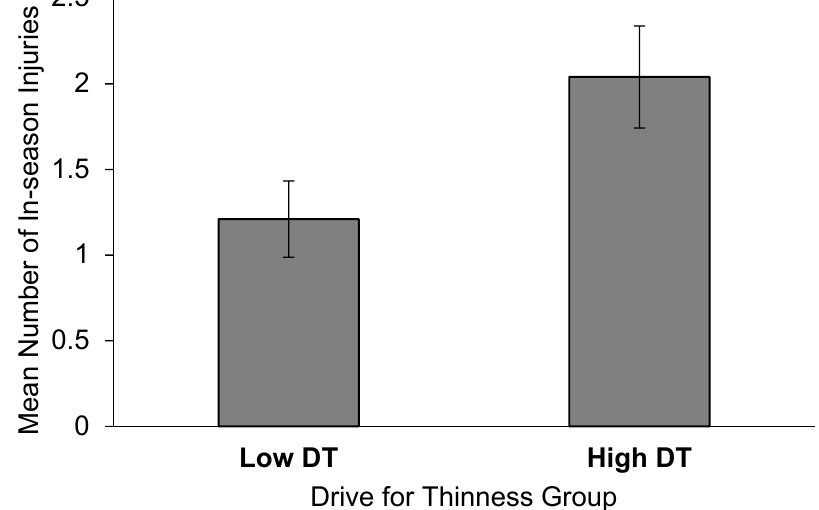
Figure 1. The mean number of in-season injuries in women high drive for thinness (High DT, determined by a median split) was higher ( p < 0.05) than the women with a low drive for thinness (Low DT). Data are reported in mean ± SEM .